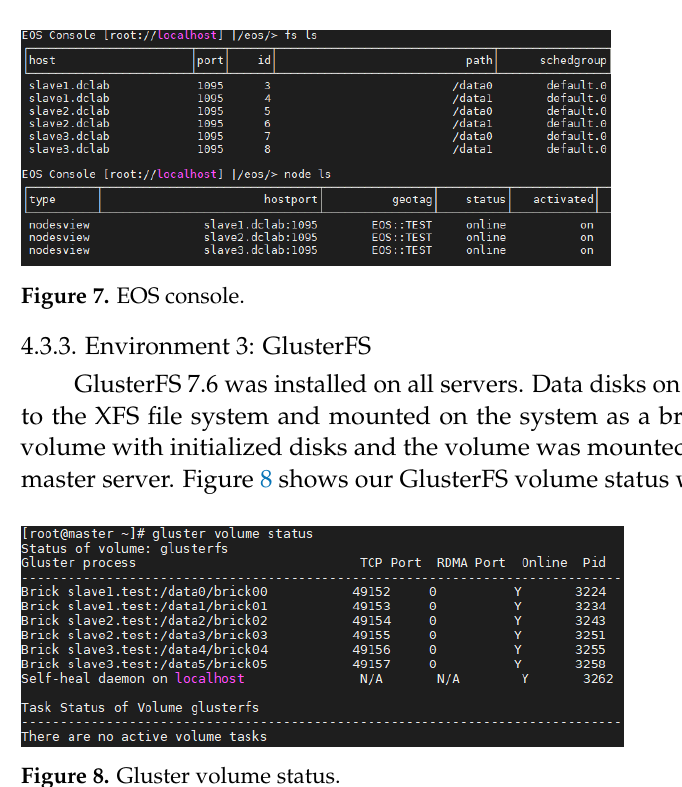
Figure 8. Gluster volume status.